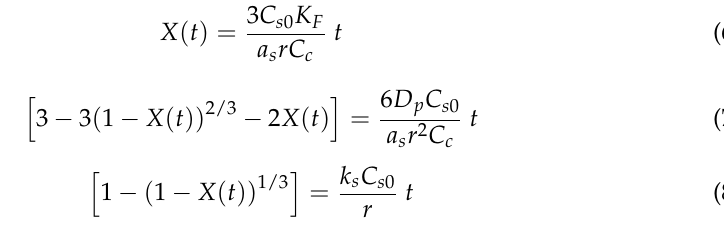
Table 4. Kinetic parameters of phosphate adsorption for adsorbents. Kinetic